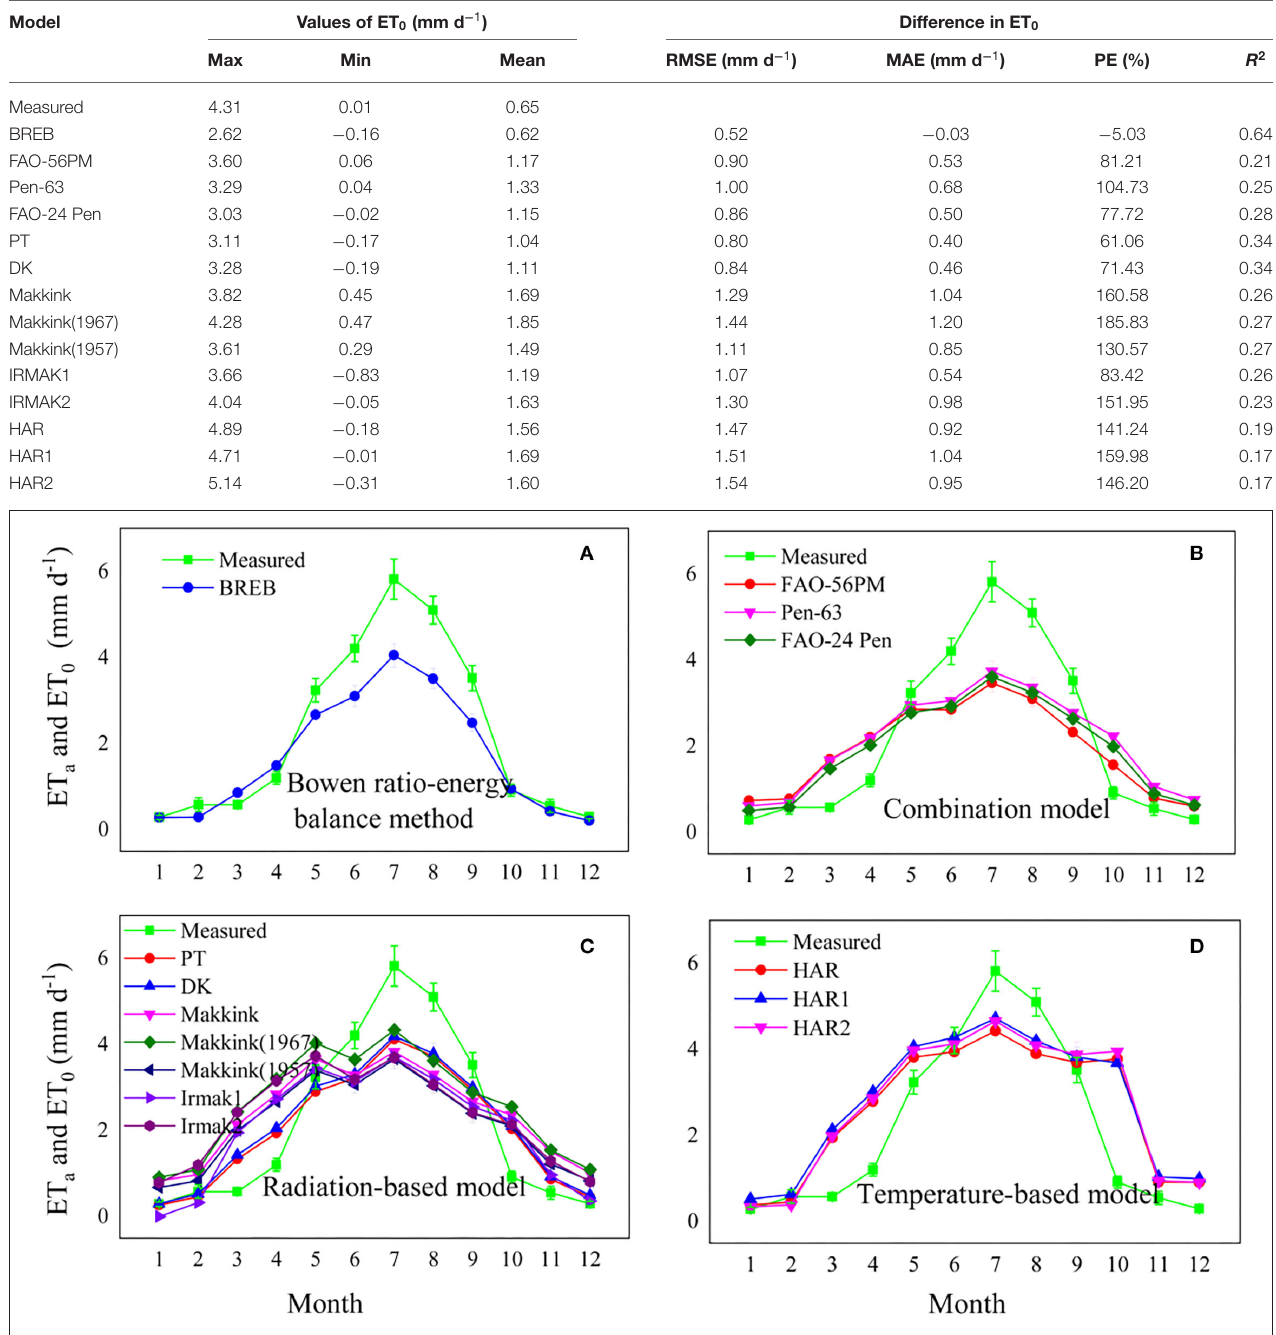
FIGURE 7 | Comparison of monthly mean daily evapotranspiration between lysimeter measurements and model estimates, (A) Bowen ratio energy balance method, (B) combination model, radiation based model (C) , and temperature-based model (D)